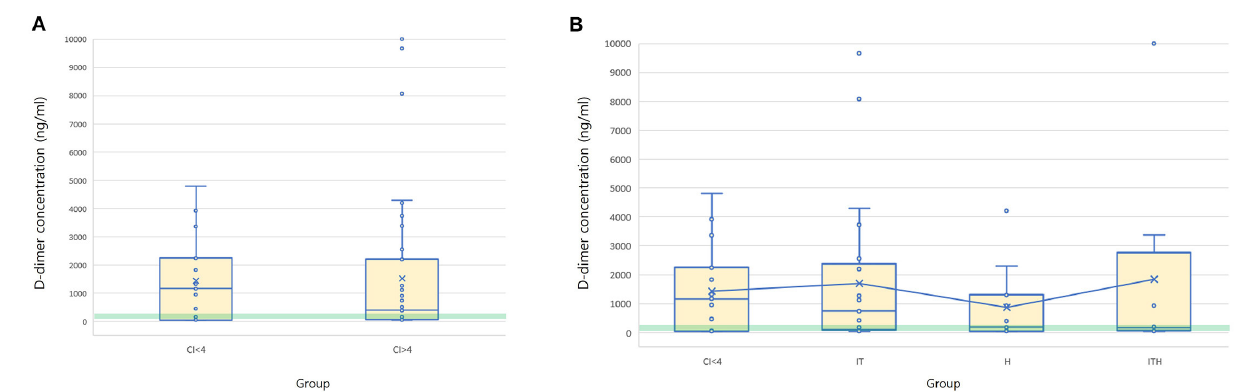
The CI calculated from the 4 TEG variables, i.e., R,